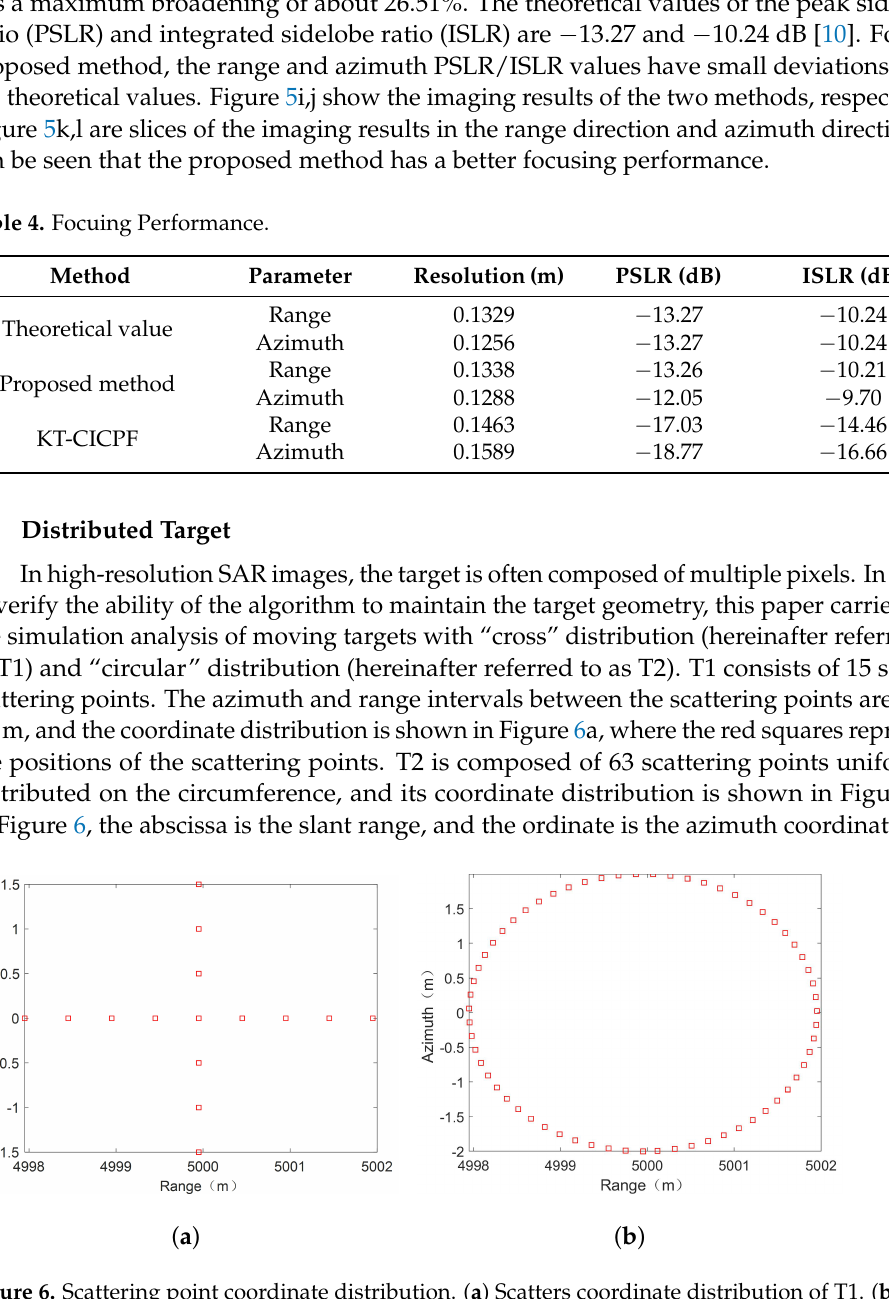
Figure 6. Scattering point coordinate distribution. ( a ) Scatters coordinate distribution of T1. ( b ) Scat- ters coordinate distribution of